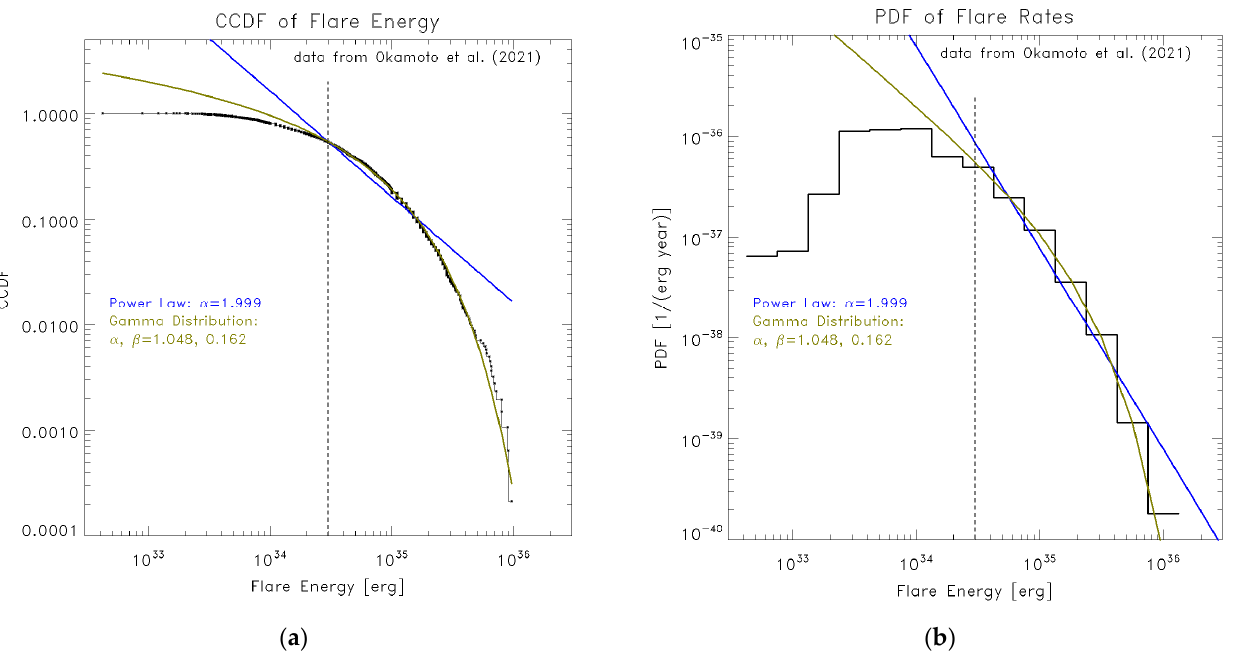
Figure 6. Statistical distributions of flares on solar-type stars. ( a ) CCDF with a power-law (blue) and gamma function (olive) distribution fits. ( b ) The histogram of flare occurrence rates with the derived power law and gamma function distributions. The data are from [39]. The vertical dashed line indicates the lower boundary (3 × 10 34 erg) of the data used for fitting.